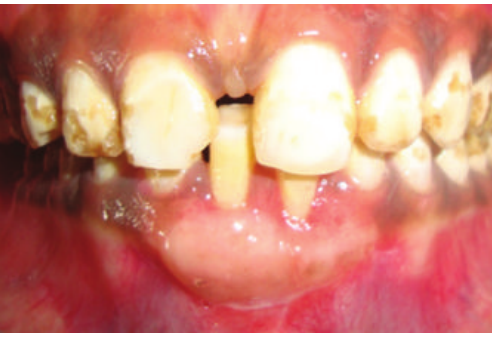
Figure 17: Six months postoperative